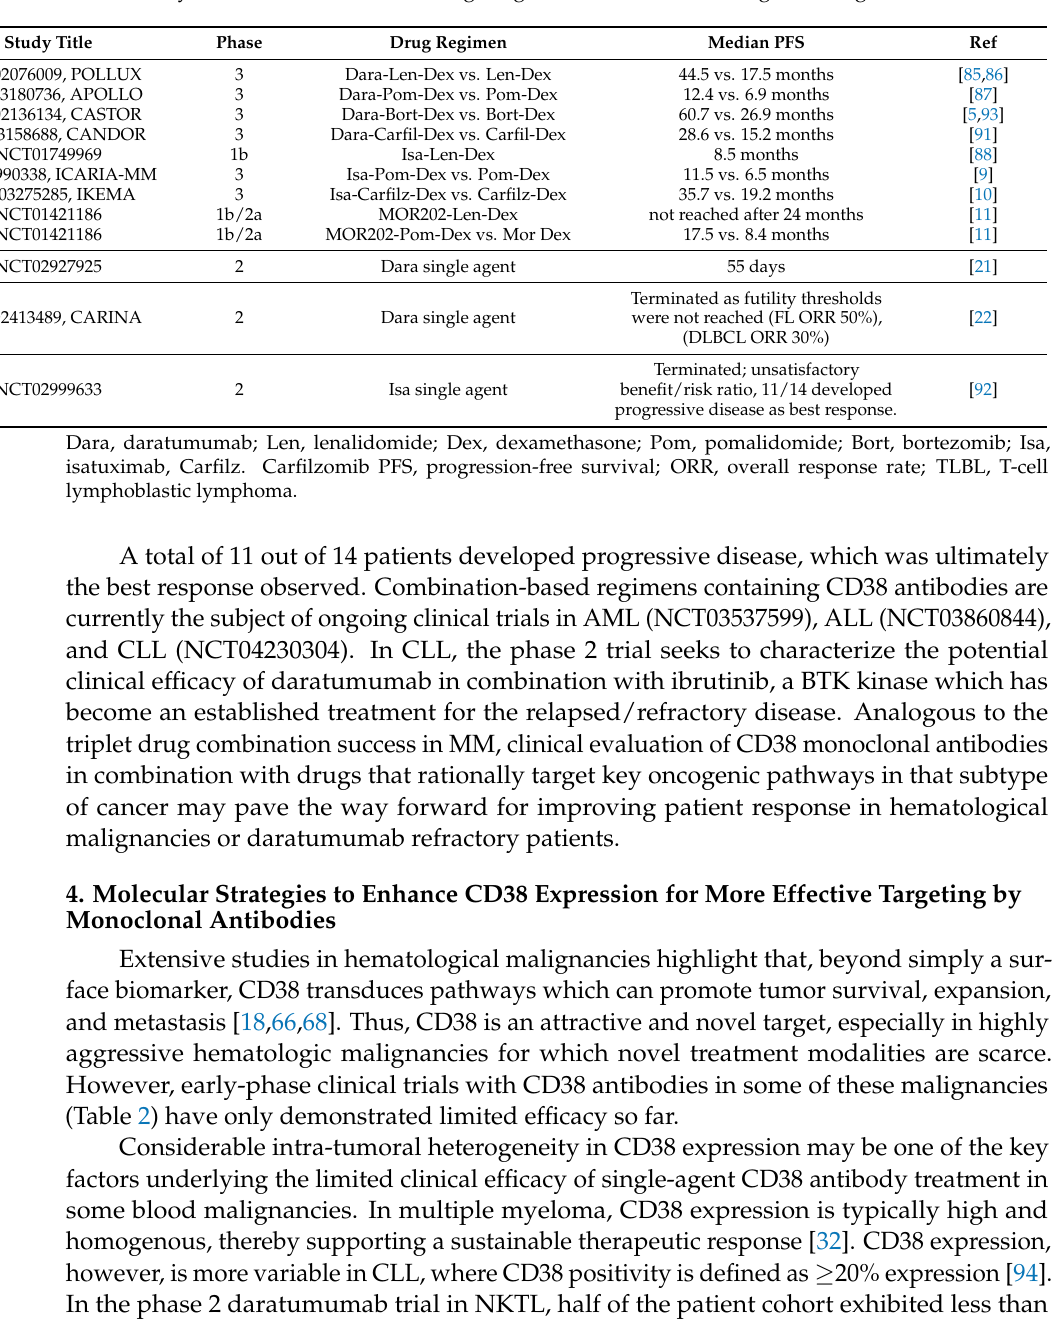
Table 2. Key clinical studies of CD38-targeting antibodies in hematological